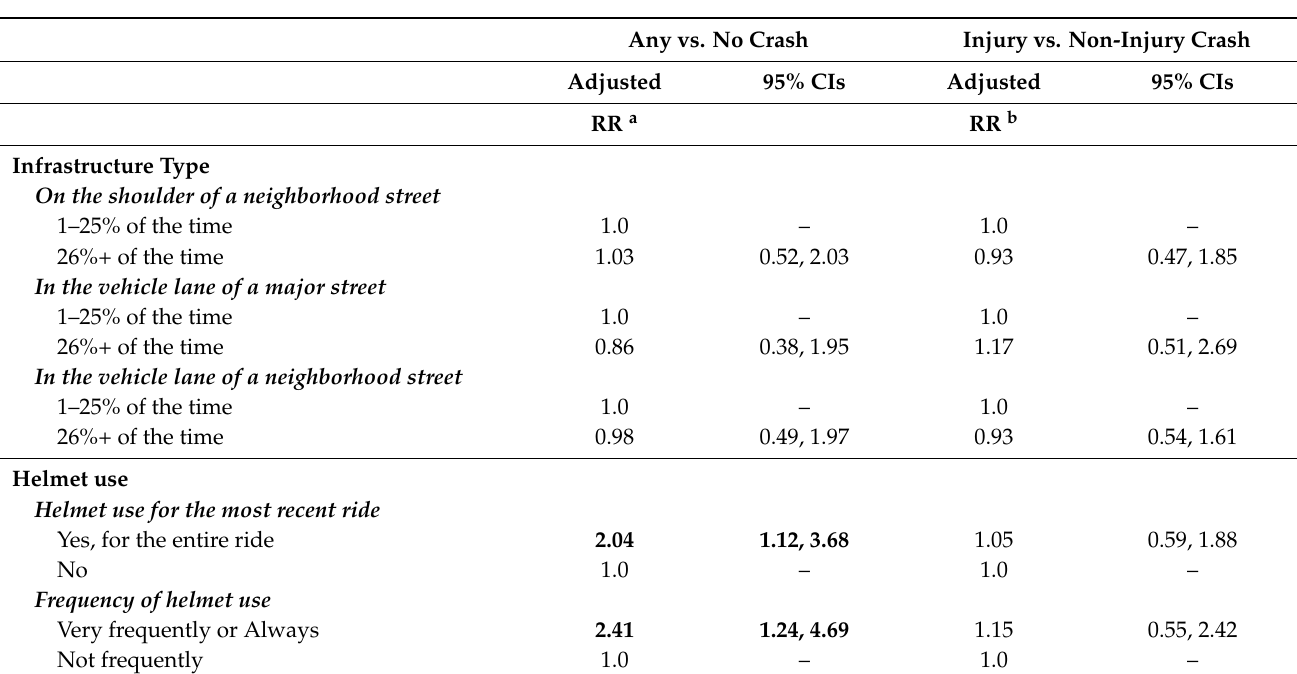
Table 2. Cont. Any vs. No Crash Injury vs. Non-Injury